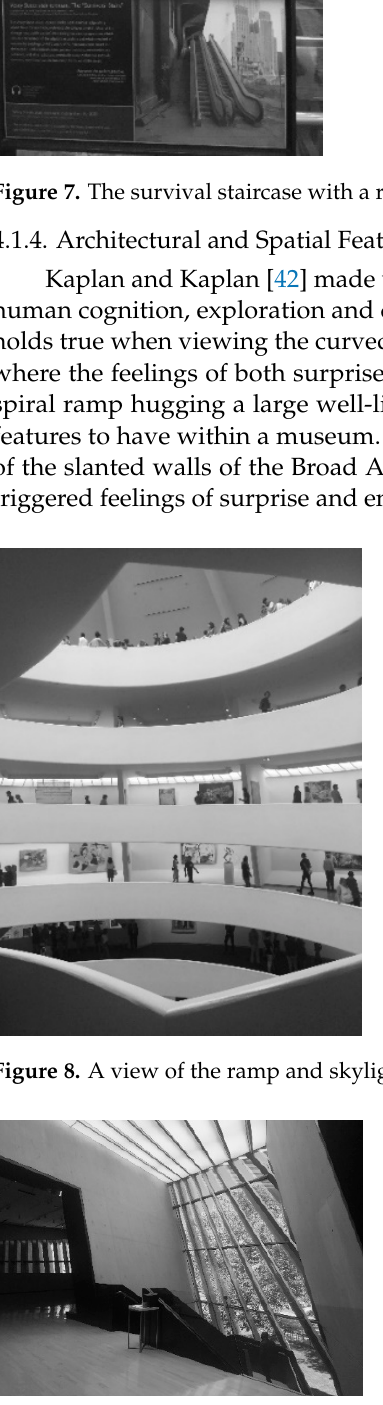
Figure 9. An interior view at the Broad Art Museum showing slanted walls and windows.